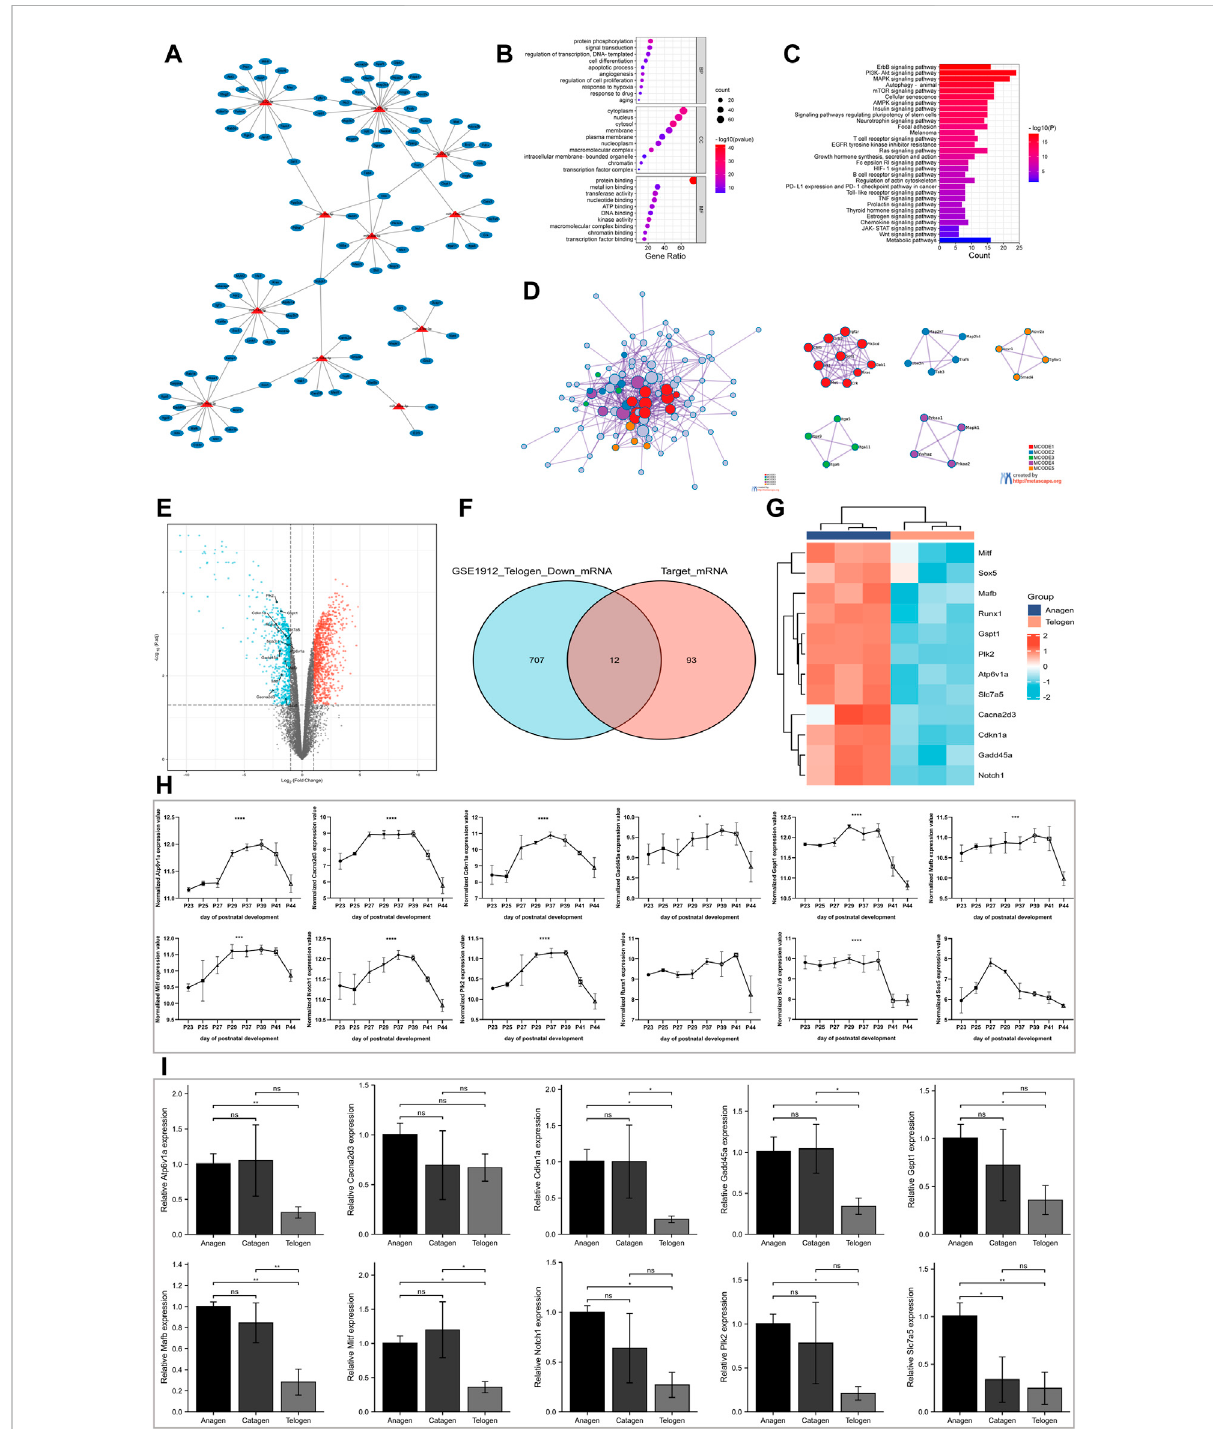
FIGURE 3 Screening for target mRNA with decreasing expression from the anagen to telogen phase in murine hair follicle cycle. (A) Construction of the miRNA-mRNA network. The miRNA-mRNA interactions were experimentally validated in previous studies. (B) The GO enrichment analysis of target mRNAs on biological processes, cellular component, and molecular function. (C) The KEGG pathway enrichment analysis of target mRNAs. (D) The PPI network analysis of target mRNAs. (E) Volcano plot shows differentially expressed mRNAs between telogen and anagen phases in the GSE1912 data set. (F) The intersection of downregulated mRNAs and target mRNAs. (G) Heatmap shows target mRNAs with decreasing expression fromtheanagentotelogenphaseintheGSE1912dataset. (H) Validationofidenti fi